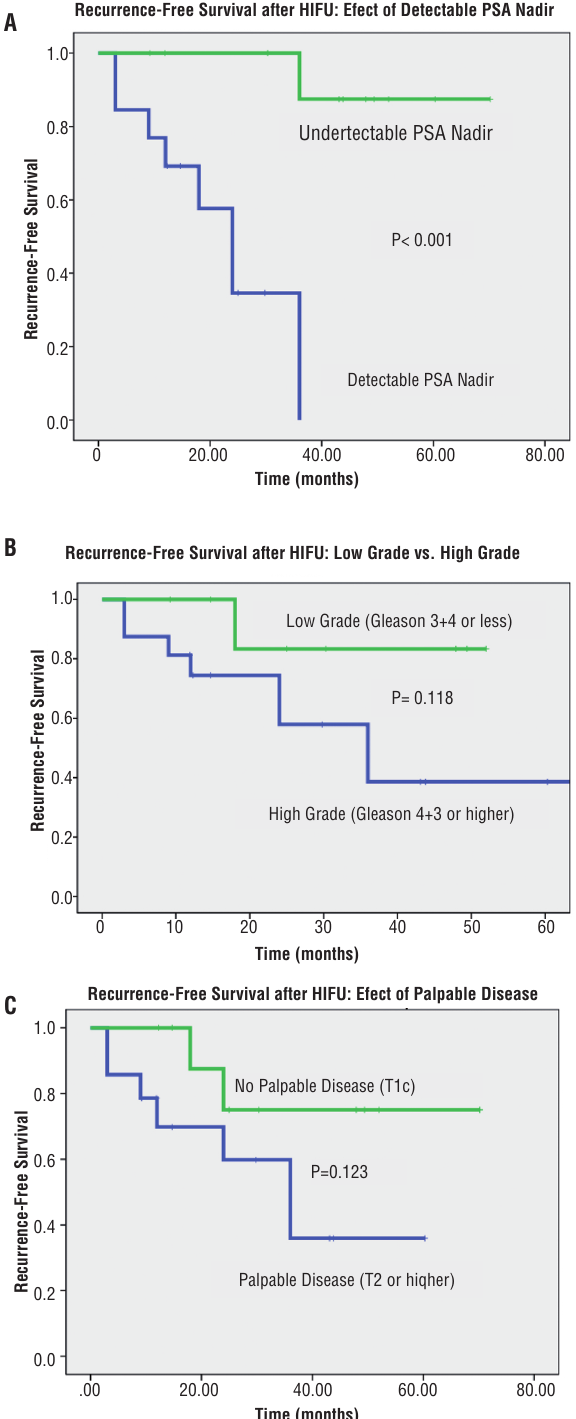
Figure 2 - Recurrence-free survival (RFS) after salvage HIFU. Figure 3 - Subgroup analysis of recurrence-free survival (RFS) after salvage HIFU. (A) PSA nadir serves as an early predictor of RFS (P<0.001). (B) Low grade and (C) impalpable disease are suggestive of improved RFS but not statistically signifi cant. Recurrence-Free Survival after HIFU: Efect of Detectable